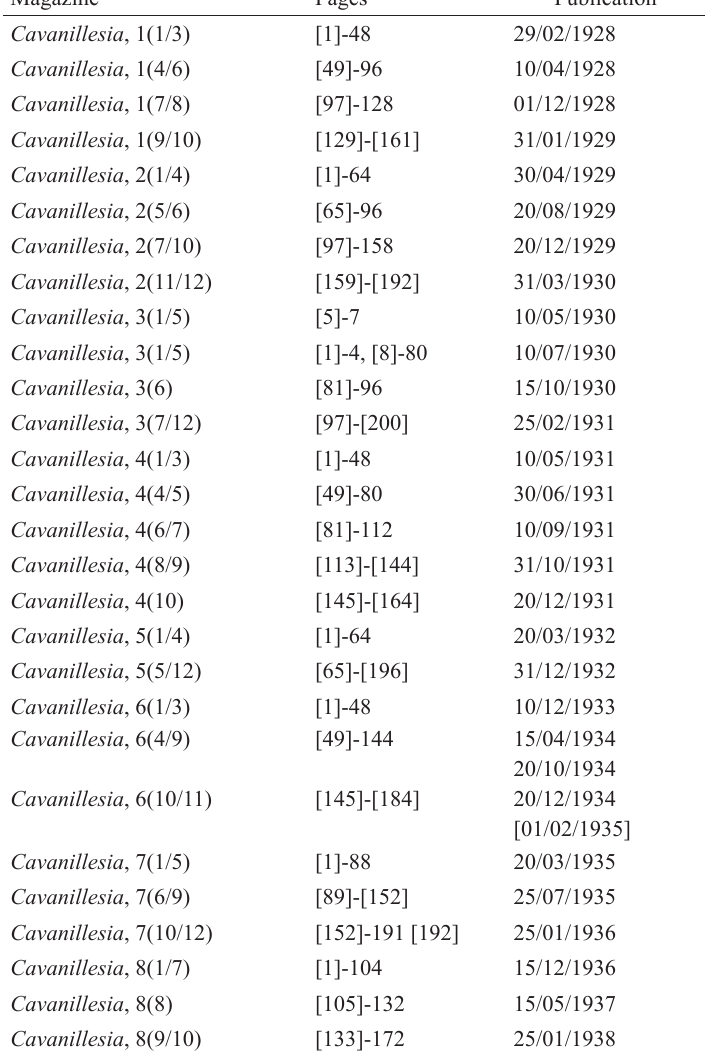
Table 1. Cavanillesia effective publication dates